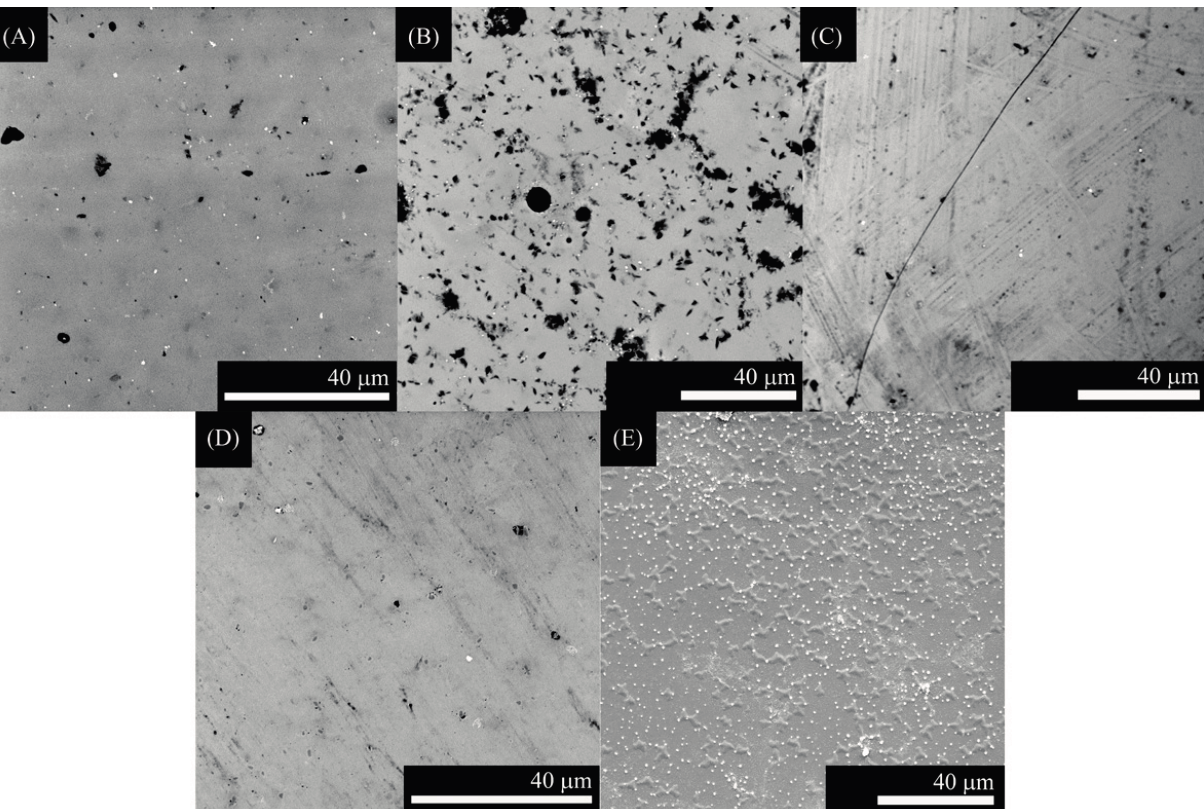
Figure 3. Scanning electronic micrographs of the top surface of ZnO35 coatings on the following substrates: ( A ) Ti alloy in argon; ( B ) Ti alloy in air; ( C ) Ta in argon; ( D ) Nb in argon; and ( E ) stainless steel in air.